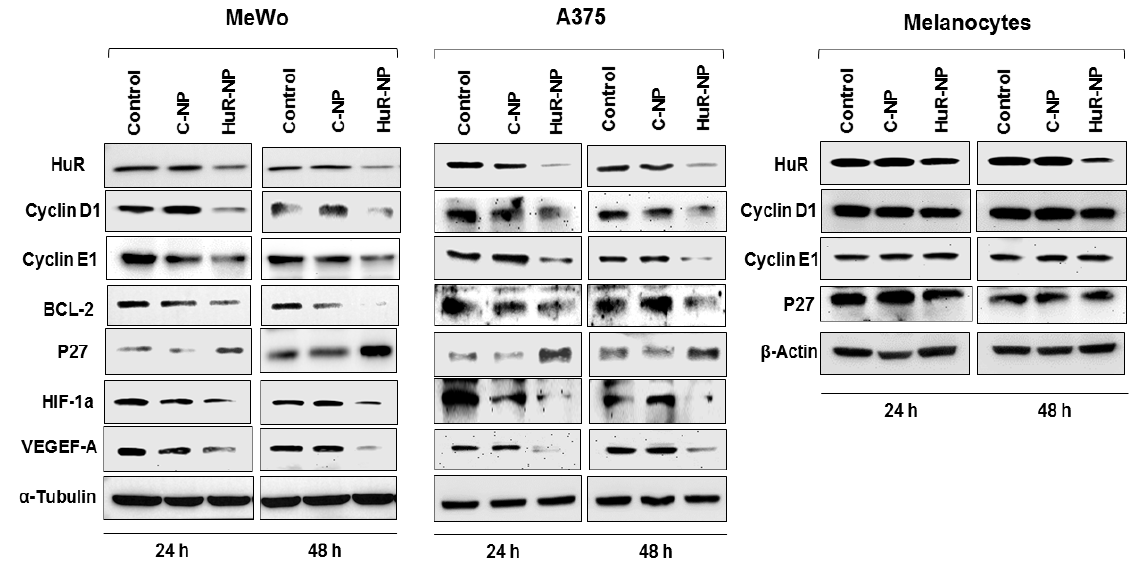
Figure 2. HuR-NP downregulates the expression of HuR and HuR-regulated proteins. Expression of HuR and HuR-regulated proteins in melanoma cell lines (MeWo, A375) and melanocytes at 24 h and 48 h after treatment with either C-NP or HuR-NP. Untreated cells served as control. β -actin and α -tubulin were used as loading controls.